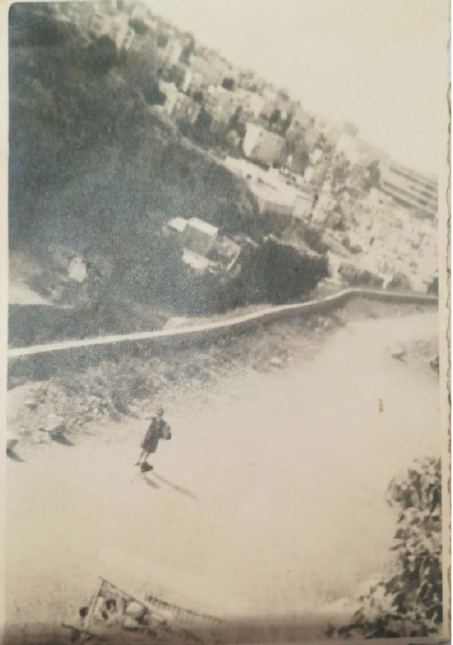
Figure 3 the way leading to upper part of the Wadi, with some houses in the background, 1960s source: The Private Family collection of the Hoffer Family and Ilan